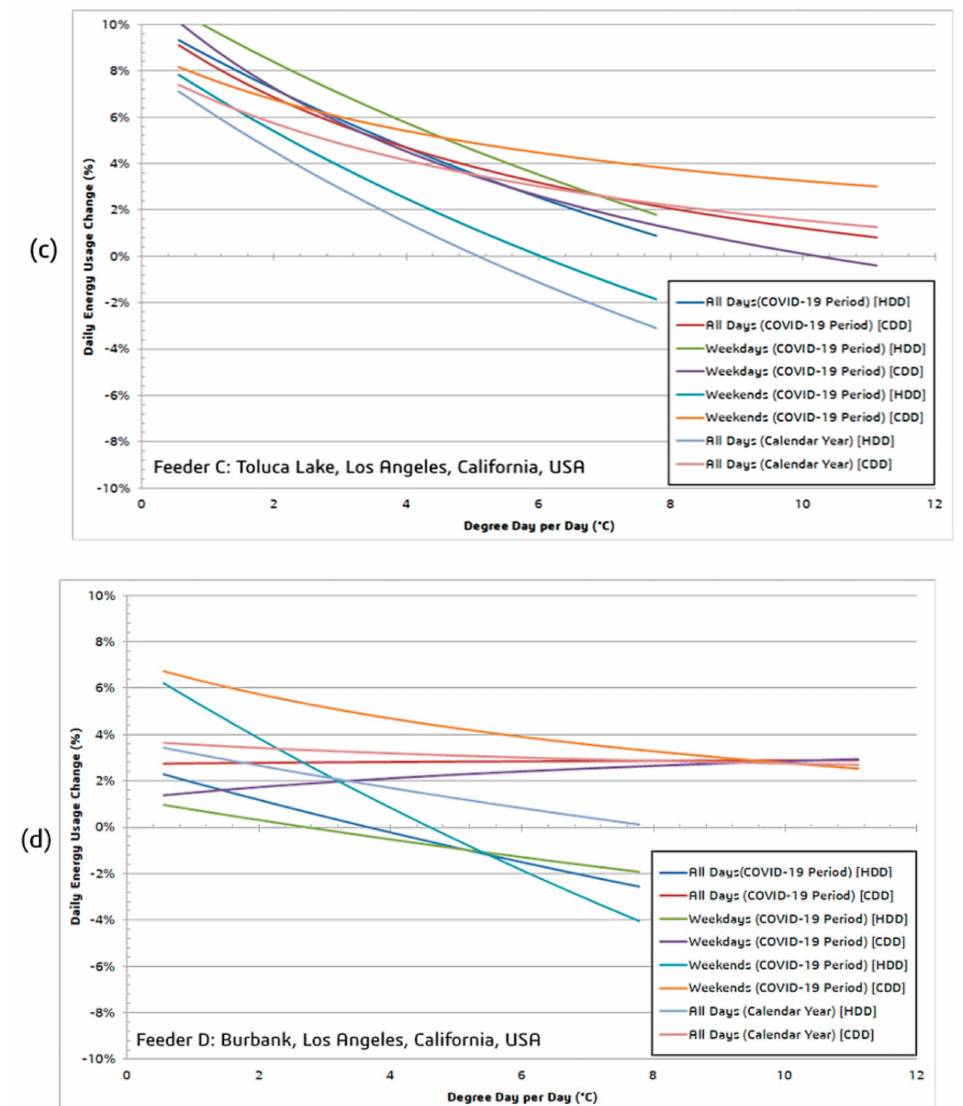
Figure 7. ( a – d ) Modeled normalized load change for 2020 compared to the baseline period for both calendar year periods (2020 to a 2018–2019 baseline) and subsets of mid-March through December for all periods comparing change in load relative to the baseline for a range of CDD and HDD values for each of the four feeders ( a ) Feeder A, ( b ) Feeder B, ( c ) Feeder C, ( d ) Feeder D. See Figure S2/Table S3 for a similar presentation of this data using normalized MST values and average daily temperatures as opposed to HDD and CDD